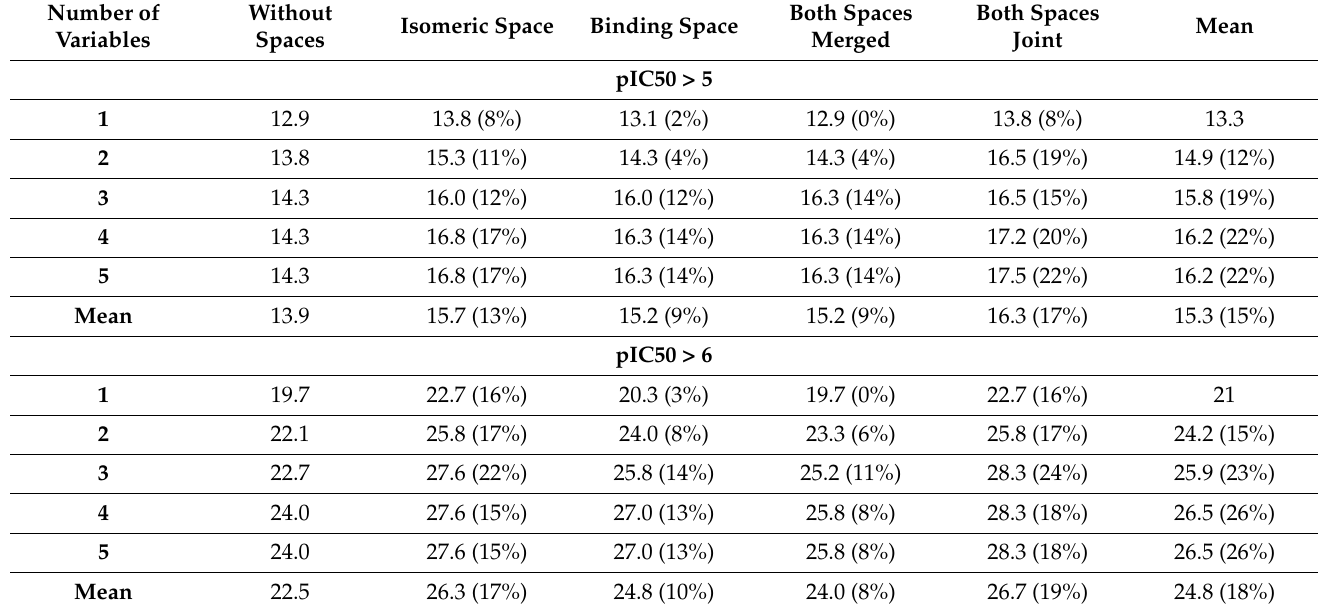
Table 5. Best EF1% values reached by the various consensus models developed using the Glide results plus the relative average values and the corresponding performance enhancements in percentage values. As described under Methods, the consensus equations were generated by linearly combining from two to five docking scores. The EF1% values referring to one variable correspond to the performances reached by single scoring